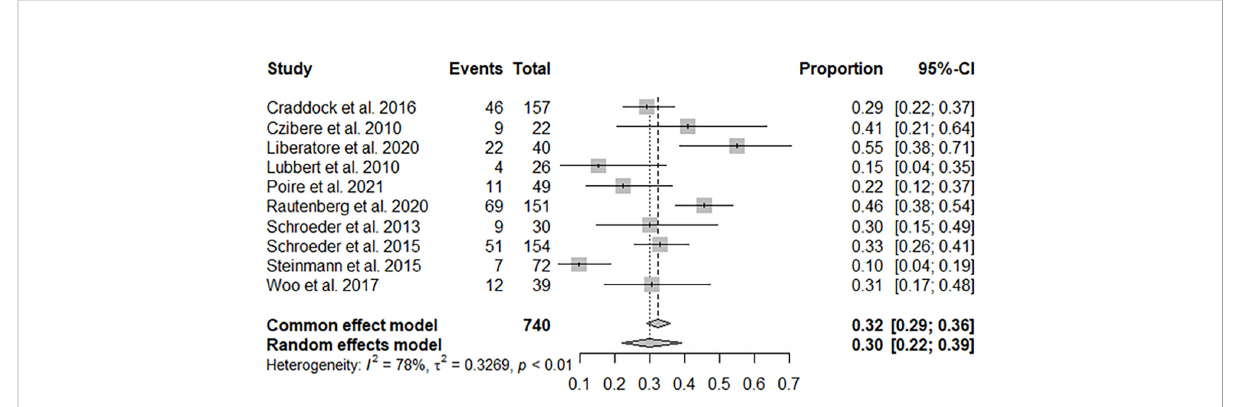
FIGURE 2 Pooled complete remission (CR) + partial remission of azacitidine and donor lymphocyte infusion (DLI)